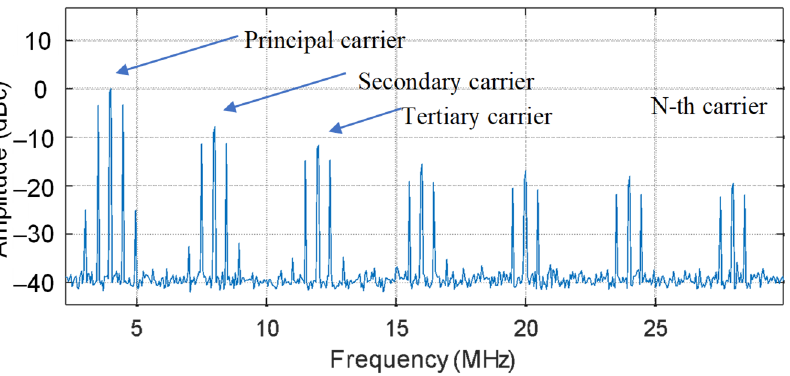
Figure 7. DOFC read-out on the photo-detector. Detected signal with multiple read-out combs, each one centered on one carrier of the multiple carriers generated by the PGC.